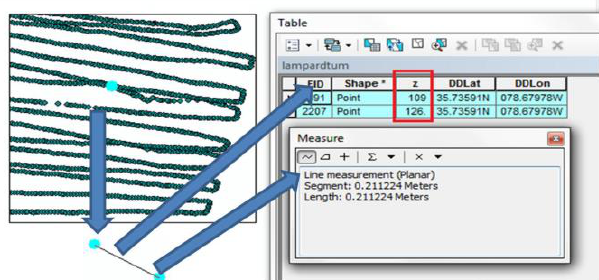
Figure 4. Accuracy of GPS